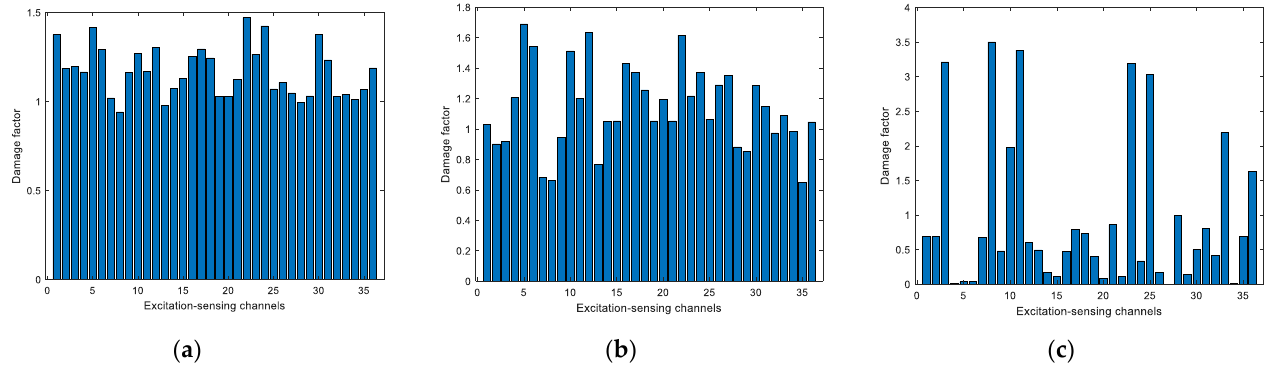
Figure 8. Results of different damage factors at 20,000 fatigue cycles: ( a ) energy damage factor; ( b ) cross-correlation damage factor; ( c ) sparse representation damage factor.